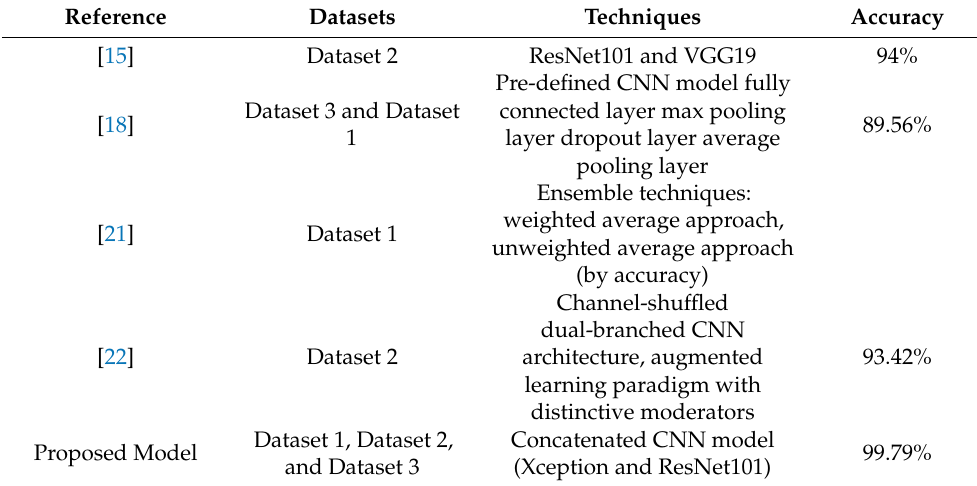
Table 13. Comparative Analysis.